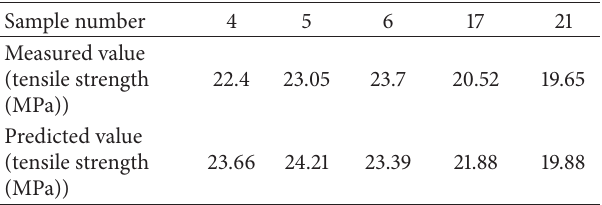
Table 7: Prediction results of tensile strength for test